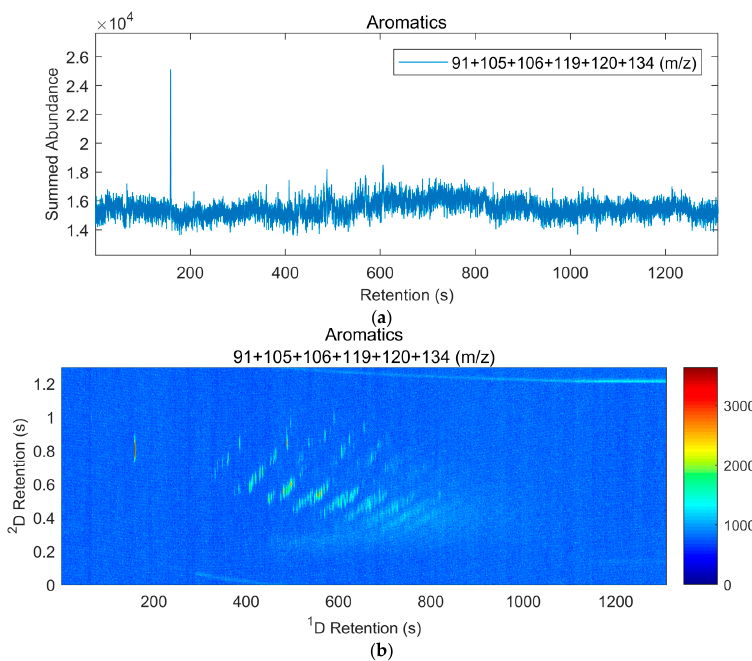
Figure 5. Heavy aromatic compounds illustrating structured retention information and high isomerism as observed on the summed aromatic EIC for the 1.0 μ L/mL diesel using: ( a ) GC-TOF; and ( b ) GC×GC-TOF. The 2 D retention axis has been shifted downwards by 0.55 s in both figures to account for the 2 D t m .